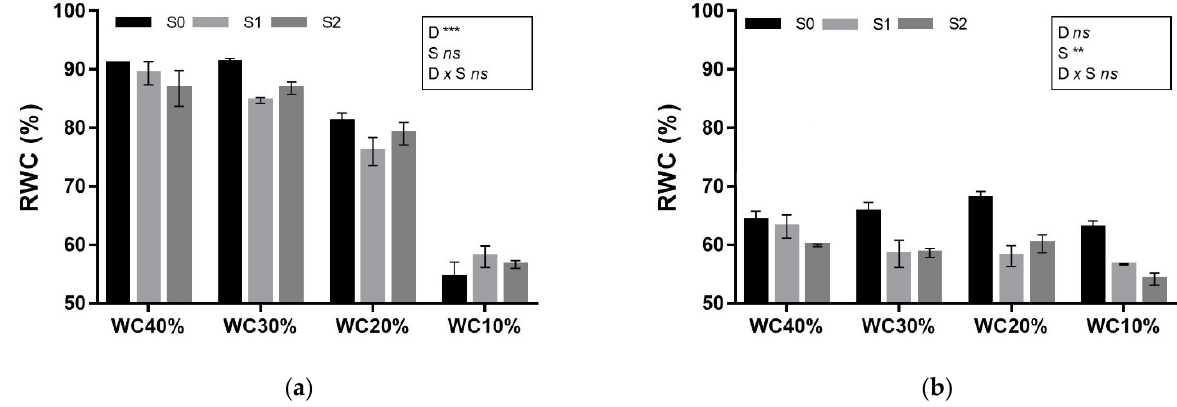
Figure 7. Relative water content (RWC) at the end of the experiment in plants of Callistemon ( a ) and Viburnum ( b ) subjected of drought (D: WC40%: control; WC30%: light drought stress; WC20%: moderate drought stress; WC10% severe drought stress) and saline aerosol treatment (S: S0: Distilled water, S1: 50% Synthetic seawater solution, S2: 100% Synthetic seawater solution). Data are means ± standard error ( n = 3). Three biological replicates were used for the measurements. Data were subjected to two-way ANOVA and differences among means were determined using Tukey’s post-test. Significance of differences of parameters: ns = not significant; ** p < 0.01; *** p < 0.001.